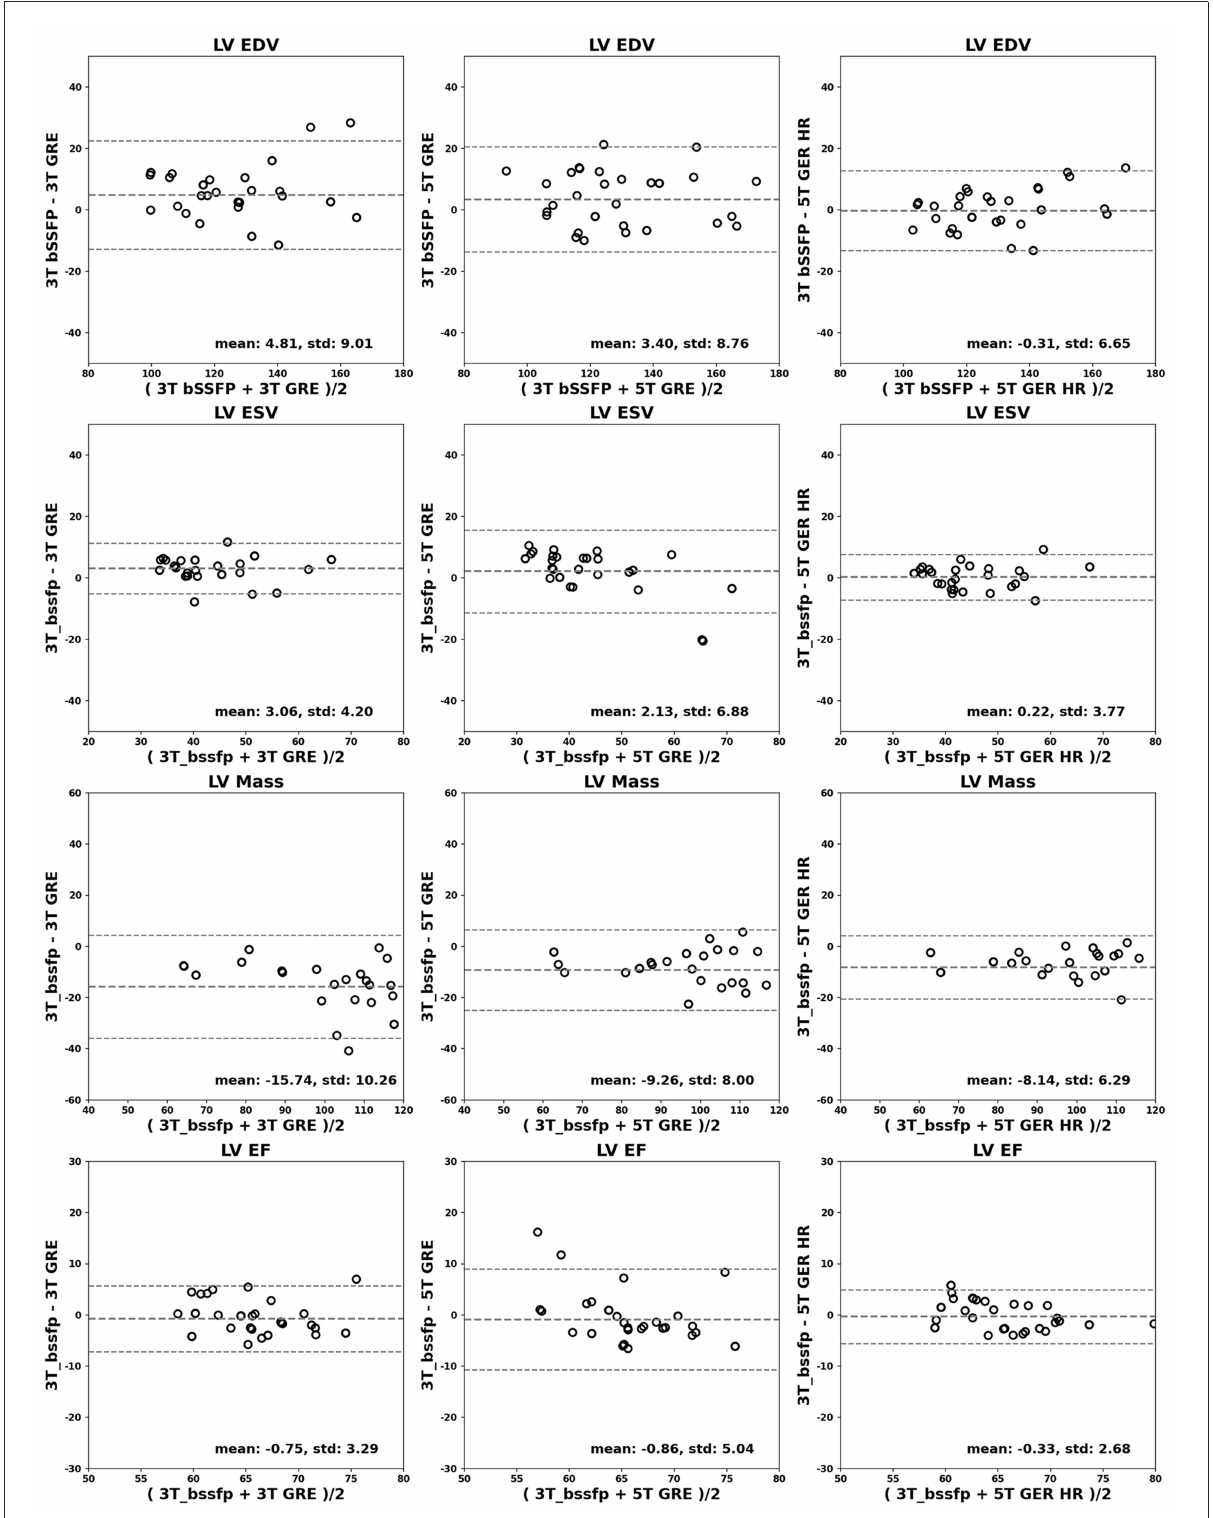
FIGURE4 Bland-Altman analyses for LV. LV EDV (ml), ESV (ml), mass (g) and EF (%) are shown in rows. Comparisons of 3T GRE, 5T GRE, and 5T GRE HR to 3T bSSFP are shown in